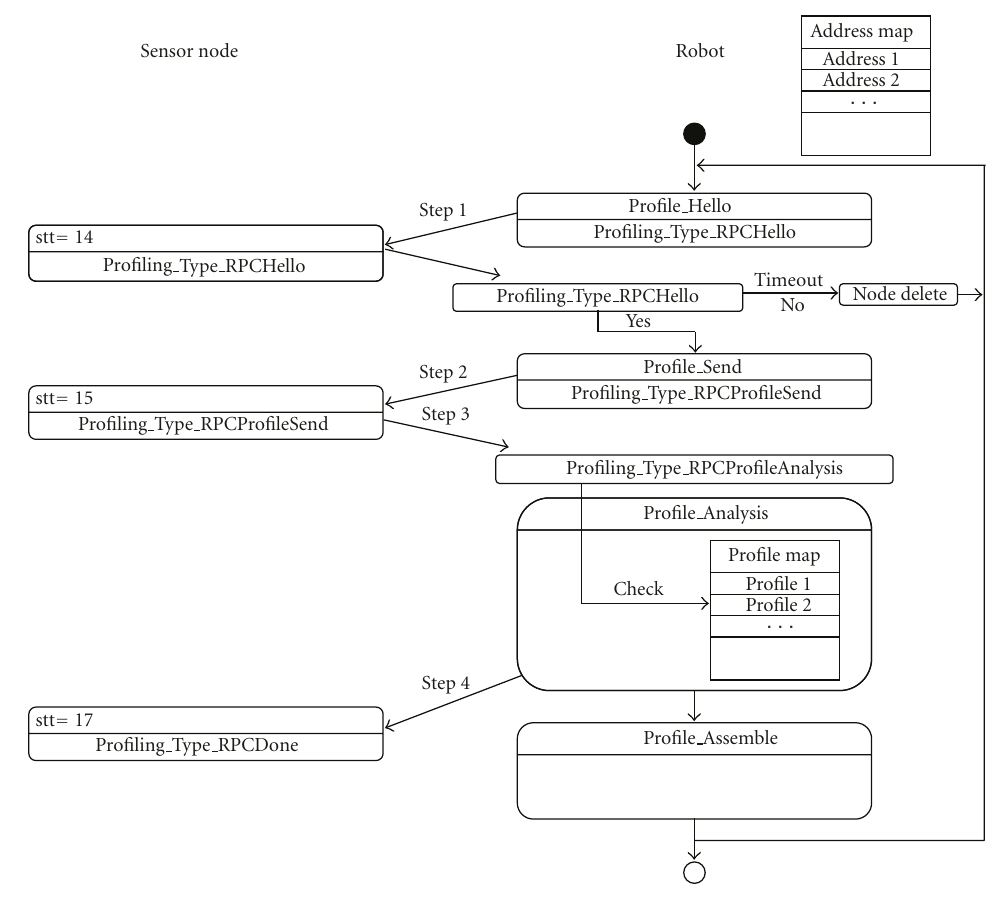
Figure 9: Communication